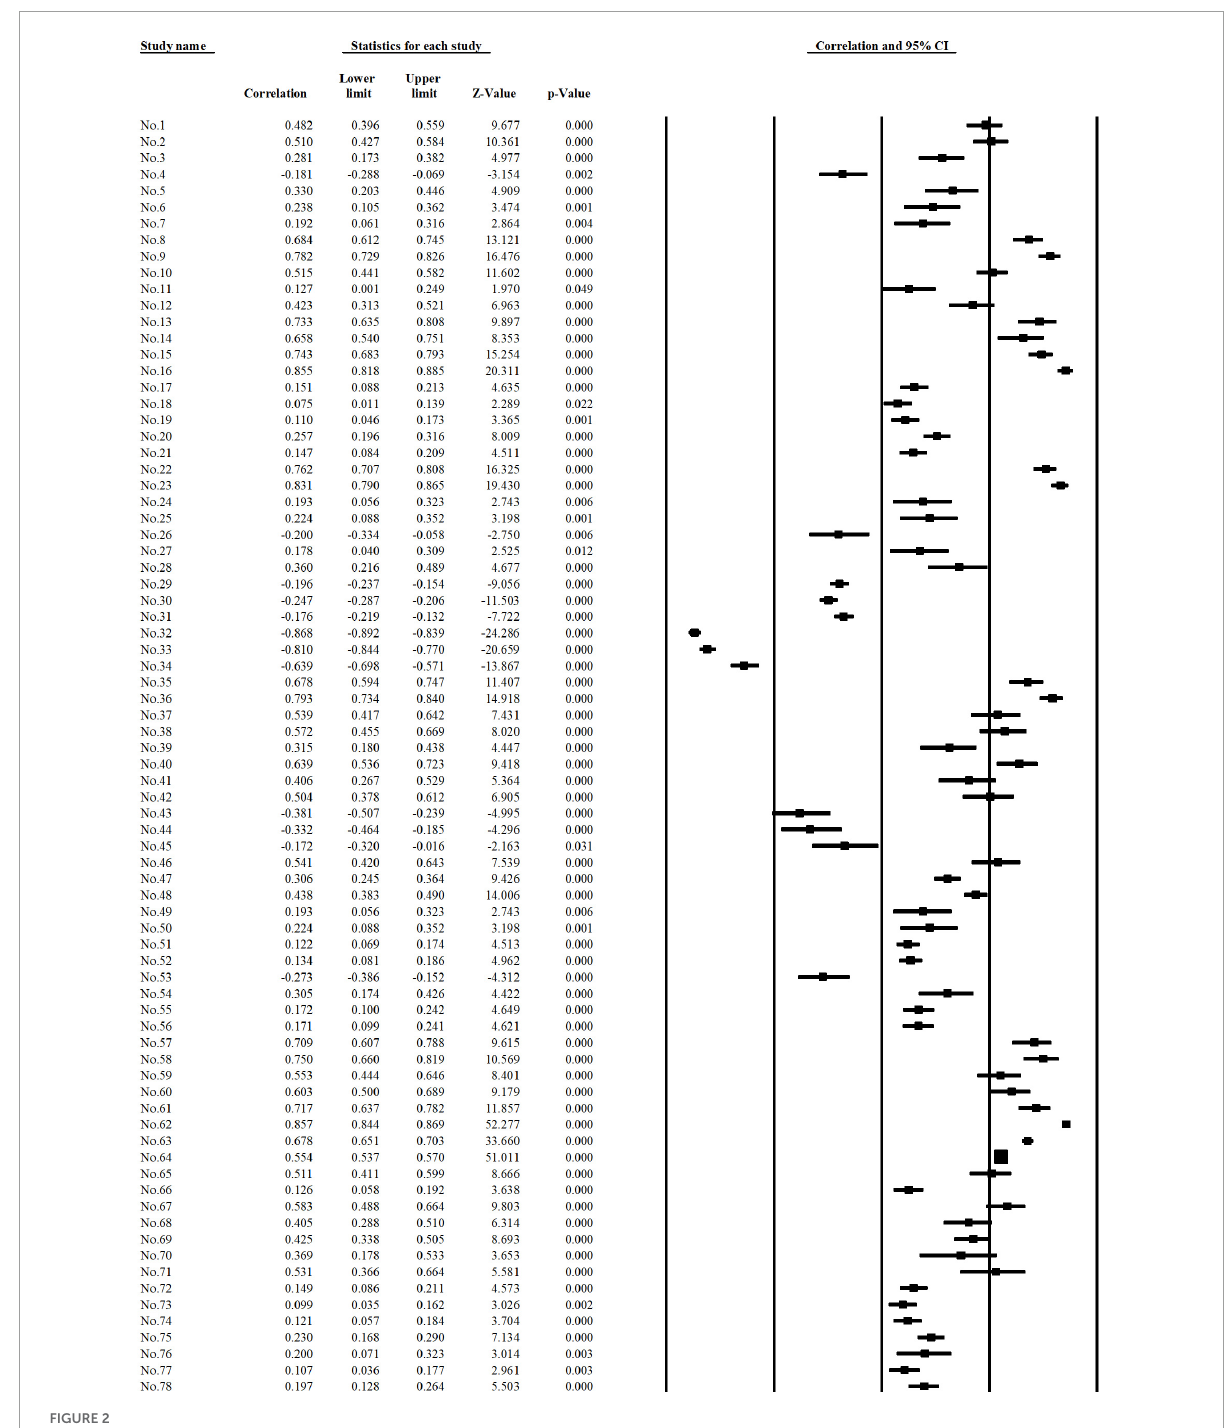
FIGURE2 Partial forest map of sample